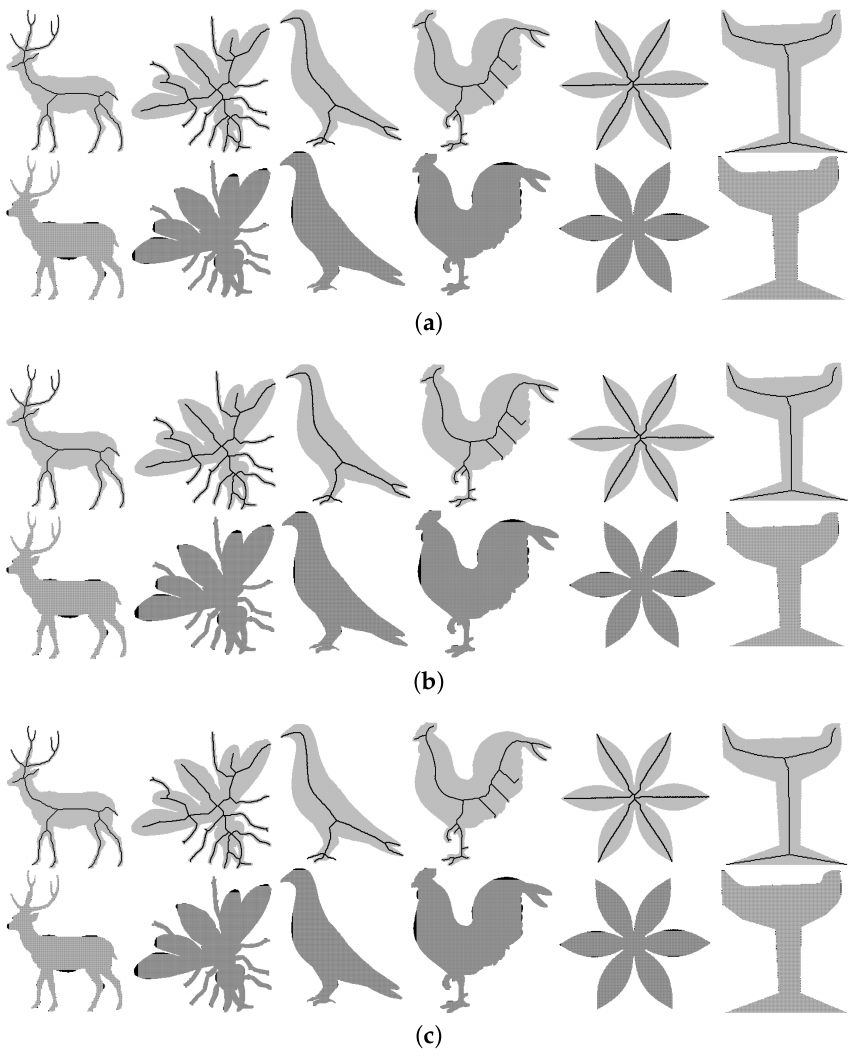
Figure 18. Results of some patterns from the MPEG7 CE-Shape-1 dataset are obtained by the three fully-parallel thinning algorithms involved in the proposed approach with the RHDP process for comparisons. Here, the thinning and reconstruction results are placed at the first and second row, respectively. The reconstruction results are near the original ones. ( a ) CH [9]; ( b ) AW [16]; ( c ) Rockett